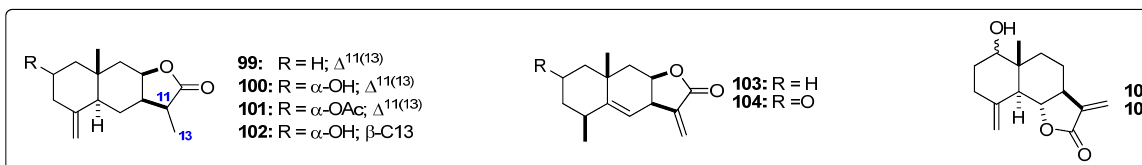
Figure 8. Structures of the tested eudesmanolide sesquiterpenes